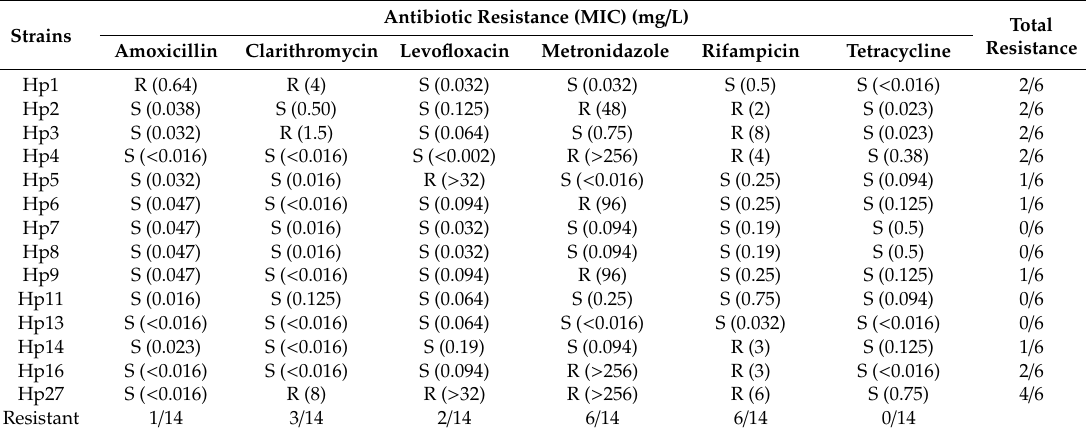
Table 2. Antibiotic resistance and MIC profile of H. pylori